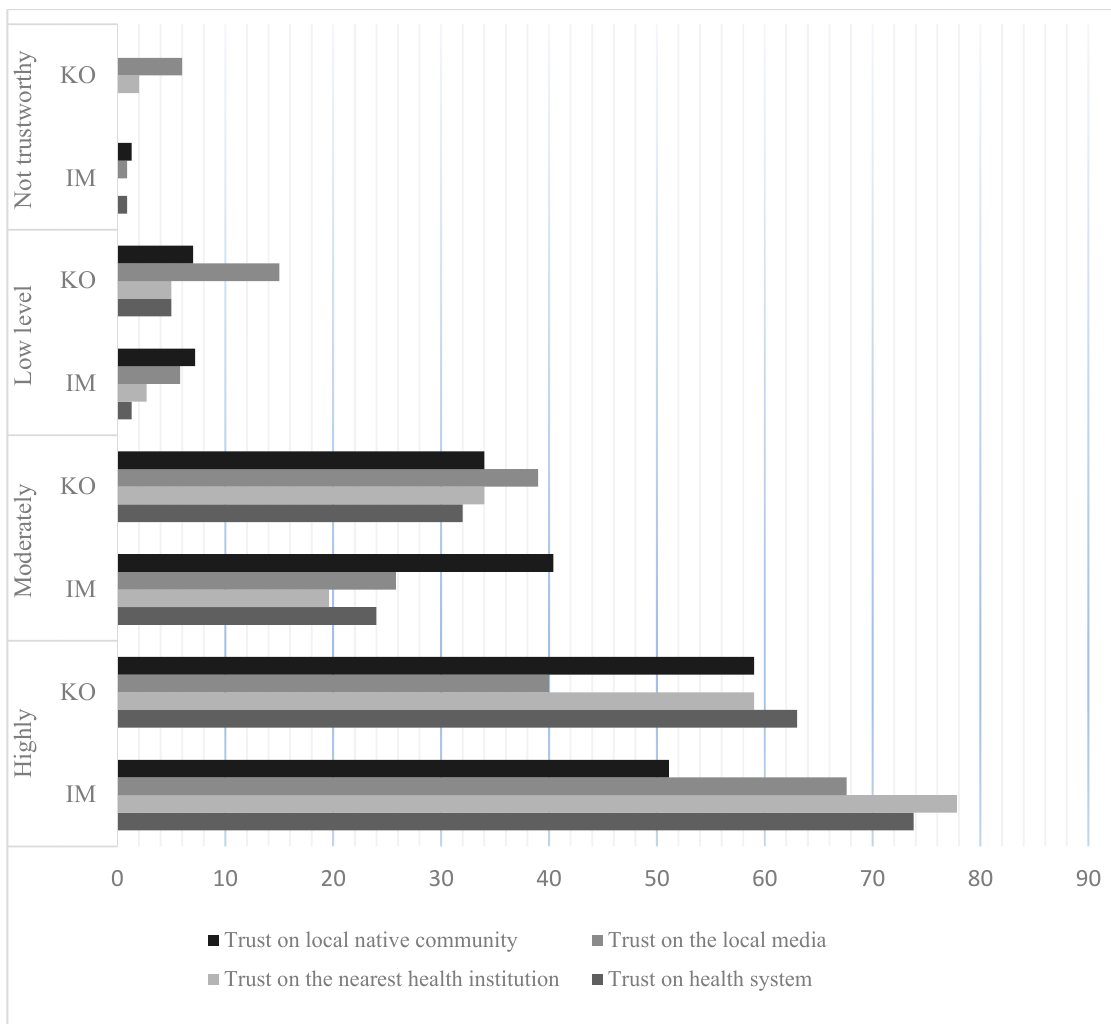
Figure 3. Individual-level trust result ( n = 407) and Koreans ( n = 100). Table 3. Mann–Whitney U-Test on panic severity